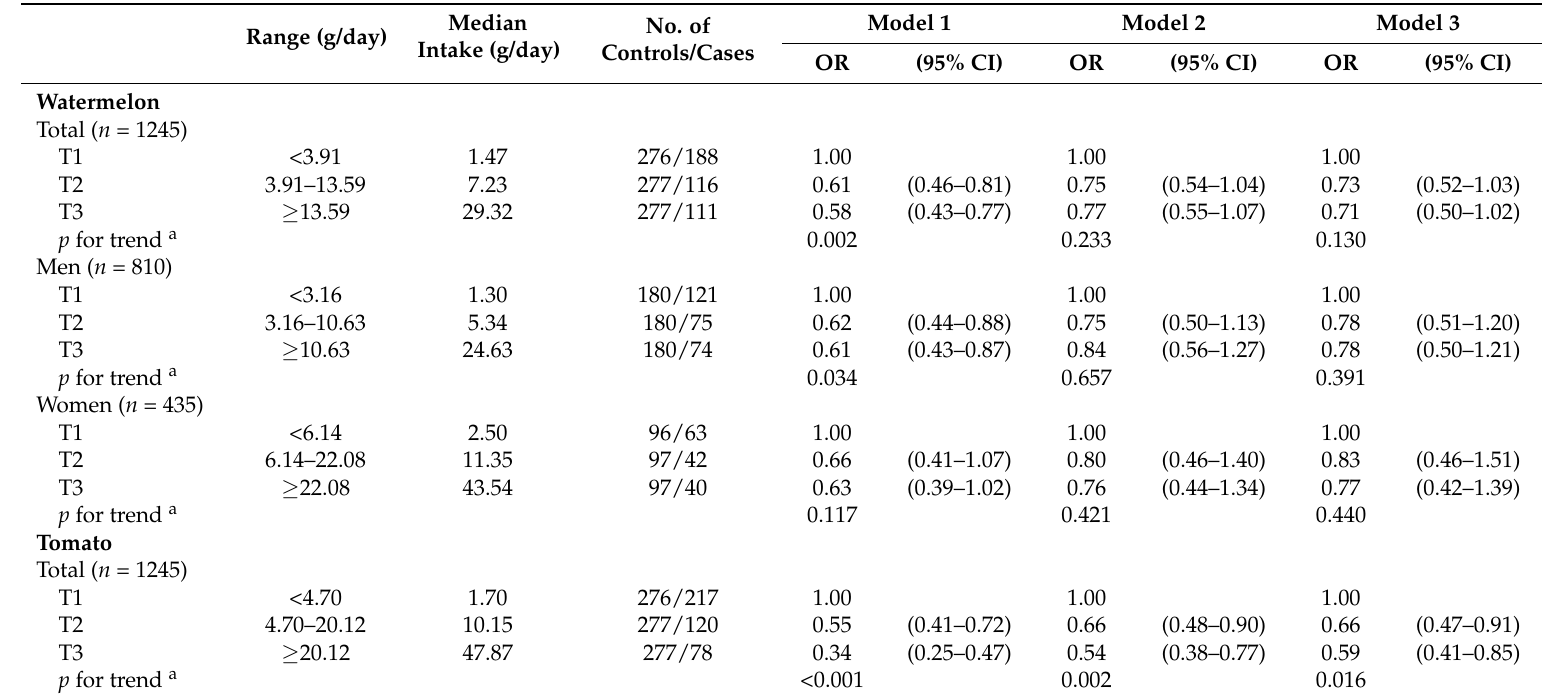
Table 7. ORs and 95% CIs of GC according to tertiles of the consumption of lycopene contributing